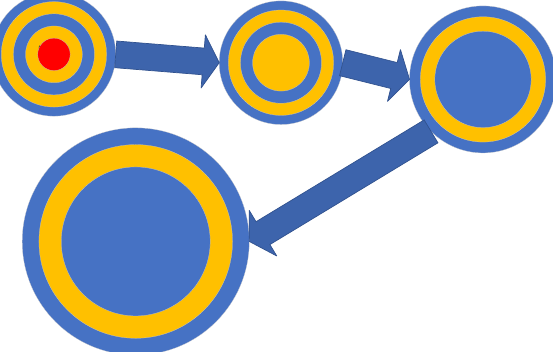
Figure 11. Evolution of an initial flocculate particle in saline water to form a water or gas-filled sphere coated in β -FeOOH. Red = n-Fe0; blue = water; orange = β -FeOOH. This can include: [ β -Fe 2 (OH) 3 ] + ; Blue arrow indicates the direction of evolutionary change.